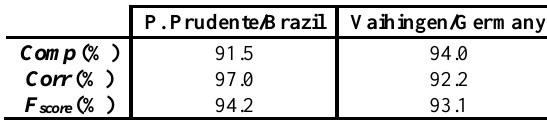
Table 3. Quality parameters of proposed method for different